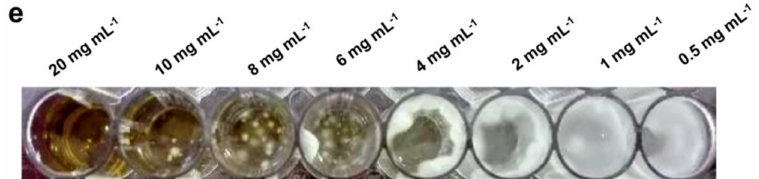
Figure 2. In vitro antifungal activity of Bacillus velezensis XT1 against Verticillium dahliae V024. ( a ) Assay on solid media with the whole culture of strain XT1. Non-inoculated tryptic soy broth (TSB) was used as a control. ( b ) Assay on modified medium prepared with the half-diluted and undiluted supernatant of strain XT1. Control consisted of medium hydrated with distilled water. ( c ) Volatile compounds antifungal test. Control consisted of non-inoculated TSB. ( d ) Crude lipopeptide extract antifungal test. Control consisted of medium hydrated with distilled water. ( e ) Minimal inhibitory concentration (MIC) of the crude lipopeptide extract determined in a liquid assay.